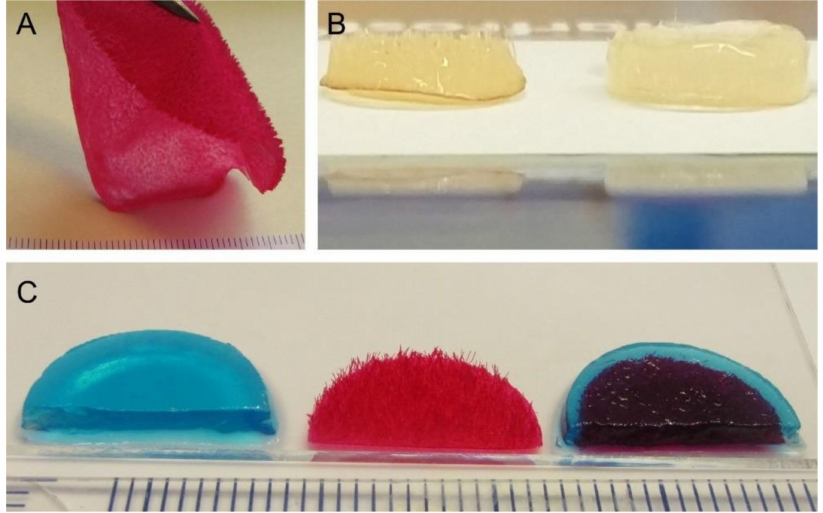
Figure 2. Images of different scaffold types: ( A ) Flocked chitosan source material after drying and neutralization in wet state, stained with Cibacron Brilliant Red 3B-A (CBr) for better visibility. ( B ) Chitosan flock scaffold without (left) and filled with alginate hydrogel (right) as used for cell culture experiments. ( C ) Pure alginate hydrogel scaffold (left), pure chitosan scaffold (middle), chitosan flock scaffold with alginate hydrogel (right). For a better representation after staining of chitosan with CBr and of alginate with Alcian blue. The scales on the rulers in ( A , C ) show mm, the scaffold diameter in ( B ) is 6